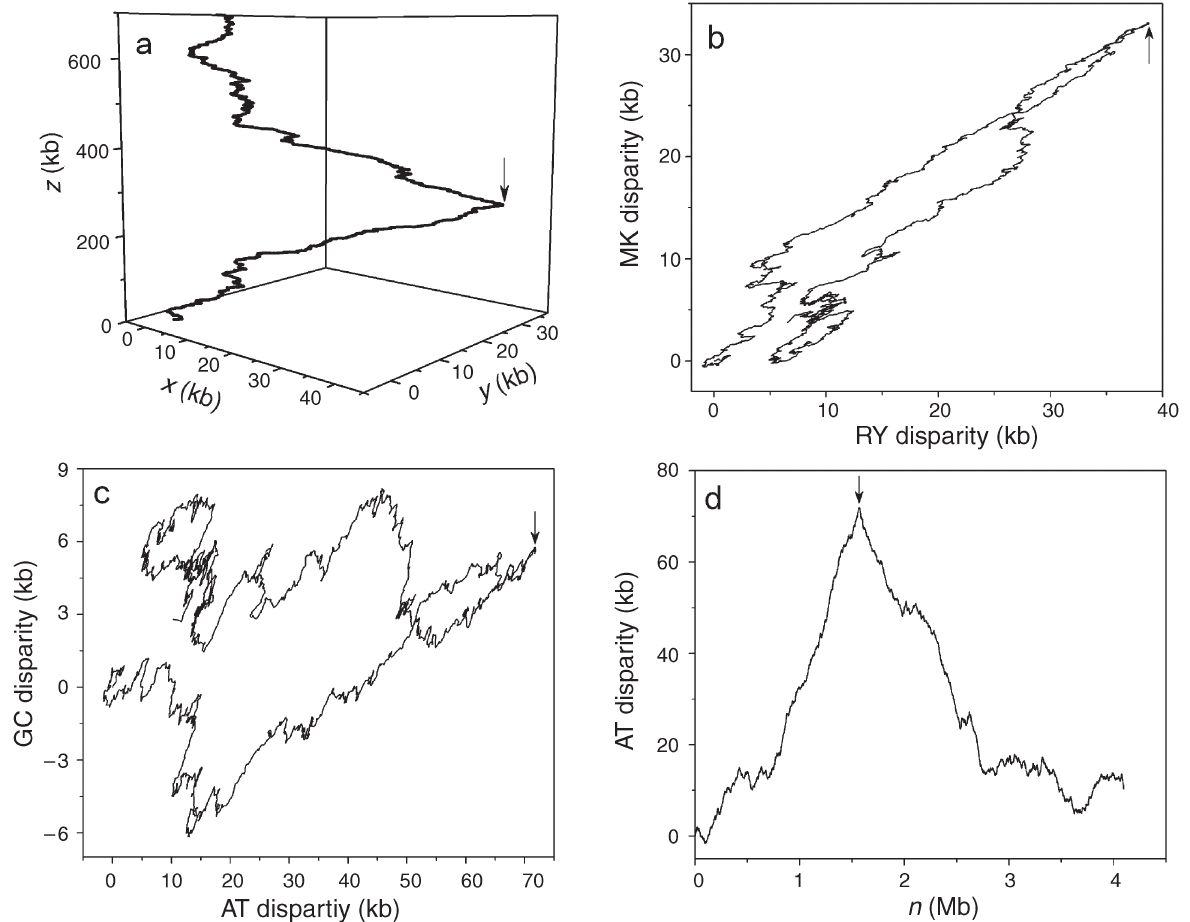
Figure 1. The Z -curves for the Methanosarcina mazei genome. (a) The 3-D Z -curve, (b) the 2-D Z -curve based on RY and MK disparity, (c) the 2-D Z -curve based on AT and GC disparity and (d) the AT disparity curves. Arrows indicate the positions of the cdc6 gene, which is also the posi- tion of the predicted replication